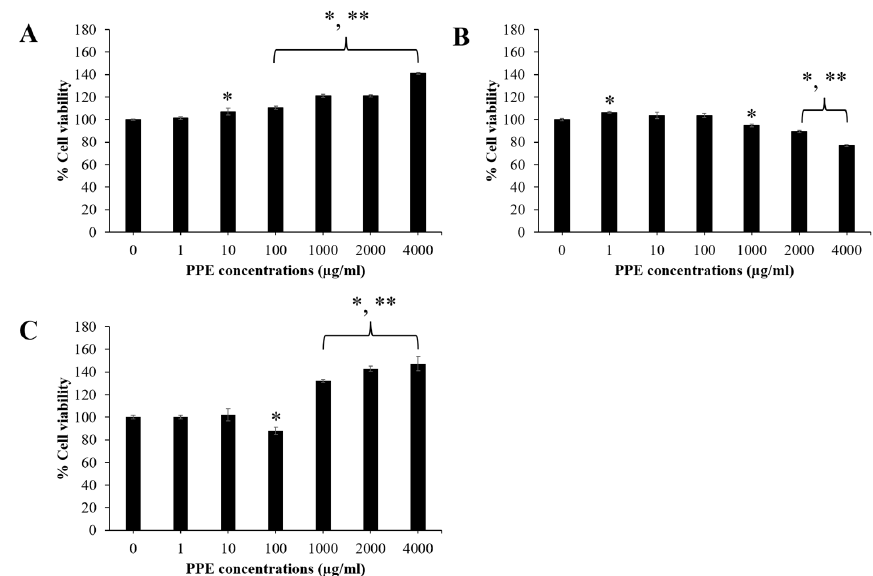
Figure 2. Effect of PPE on cell viability of ( A ) NHF; ( B ) HaCaT; ( C ) HFDPC. The cells were exposed to various concentrations (0–4000 µg/mL) of PPE for 24 h. Data are shown as mean ± SD ( n = 3). *, ** represent a significant difference from DMEM group (a negative control) at p -values of <0.05 and 0.001, respectively.